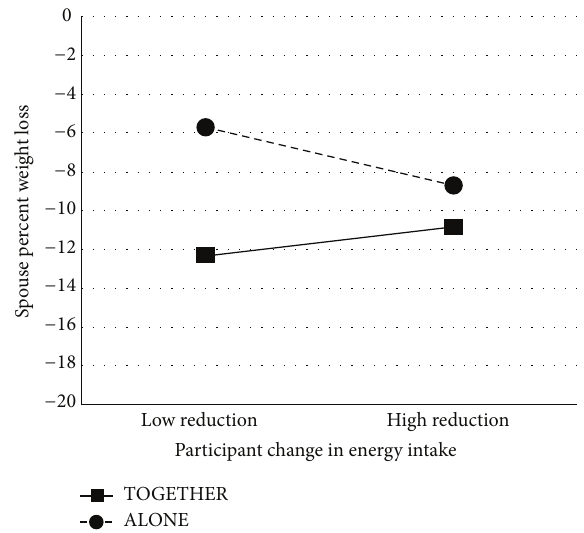
Figure 2: Interaction between treatment group and participants’ energy intake change when predicting spousal weight loss. High and low calorie reduction are defined as ± 1 SD from the mean reduction score of 546.62 kcal. “High reduction” thus corresponds to a reduction of 1295.14 kcal, and “low reduction” corresponds to a gain of 201.90 kcal.